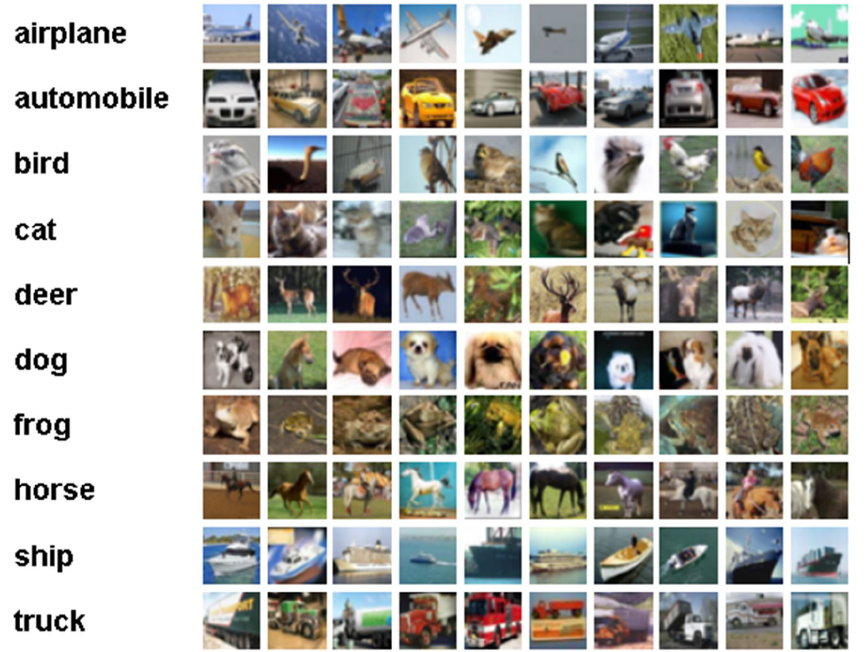
Figure 3. CIFAR-10 partial image